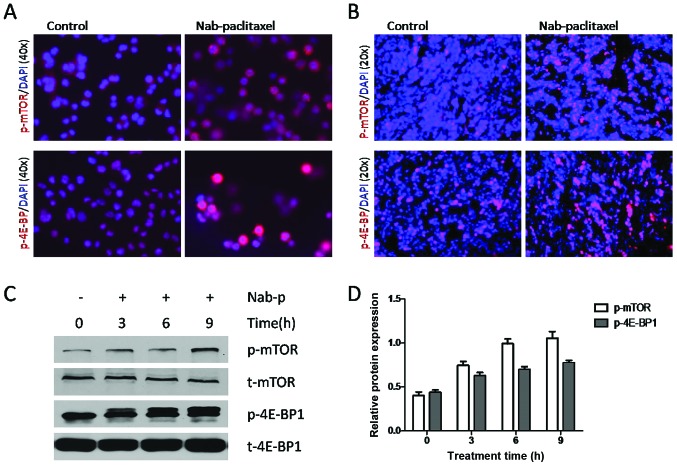
Nab-paclitaxel increases phosphorylation of mTOR and 4E-BP1 in cultured gastric cancer cells in vitro and in gastric tumors in vivo. (A) SNU16 cells were treated with nab-paclitaxel (10 μM) for 16 h and showed increased expression of p-mTOR and p-4E-BP1 by immunocytochemical staining. (B) Tumors from SNU16 xenografted mice treated with nab-paclitaxel for 2 weeks were collected on the last day of the experiment and analyzed for the expression of p-mTOR and p-4E-BP1 by immunostaining tissue sections. (C) A subconfluent monolayer of SNU16 cells was treated with nab-paclitaxel (10 μM) for 3, 6 and 9 h and analyzed by immunoblotting for p-mTOR, total mTOR, p-4E-BP1 and total 4E-BP1. (D) The intensity of bands was quantitated by densitometry and is represented in the bar graph as fraction of the total protein expression, respectively. Data are representative of three independent experiments with similar results.